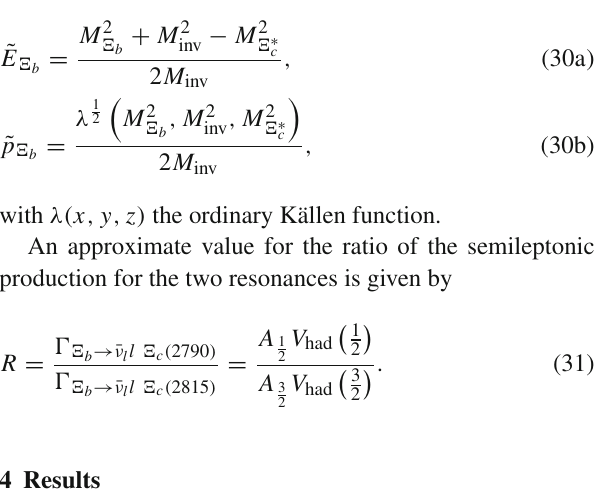
The magnitudes of (cid:2) b and its momentum in the rest frame of the ¯ ν l l pair which are given by